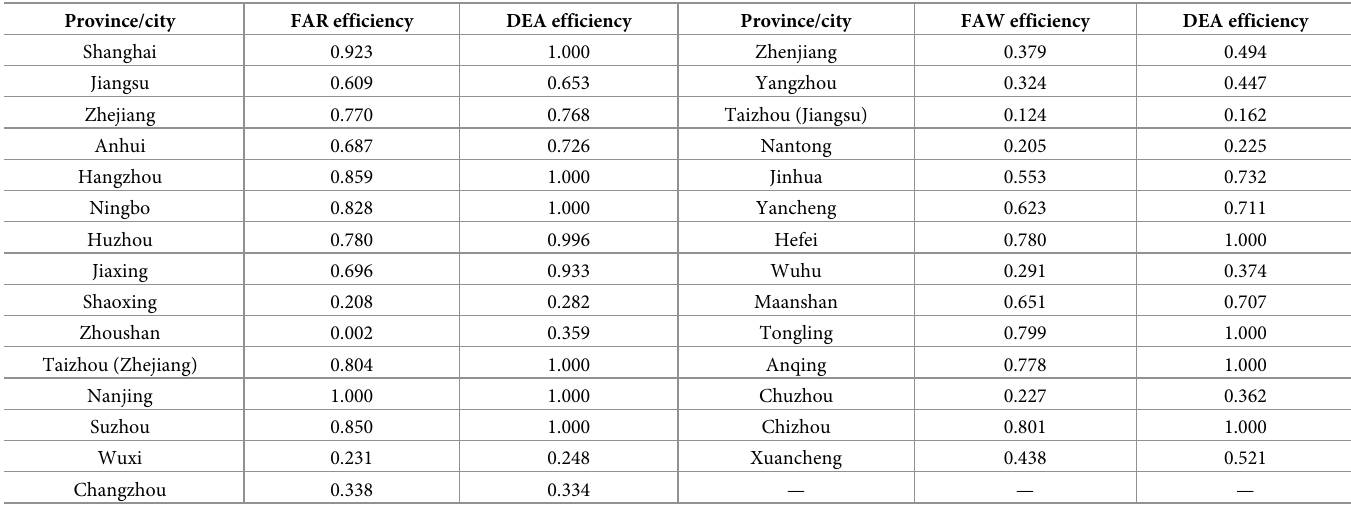
Table 4. The difference of efficiency between FAR and DEA method in 2015.